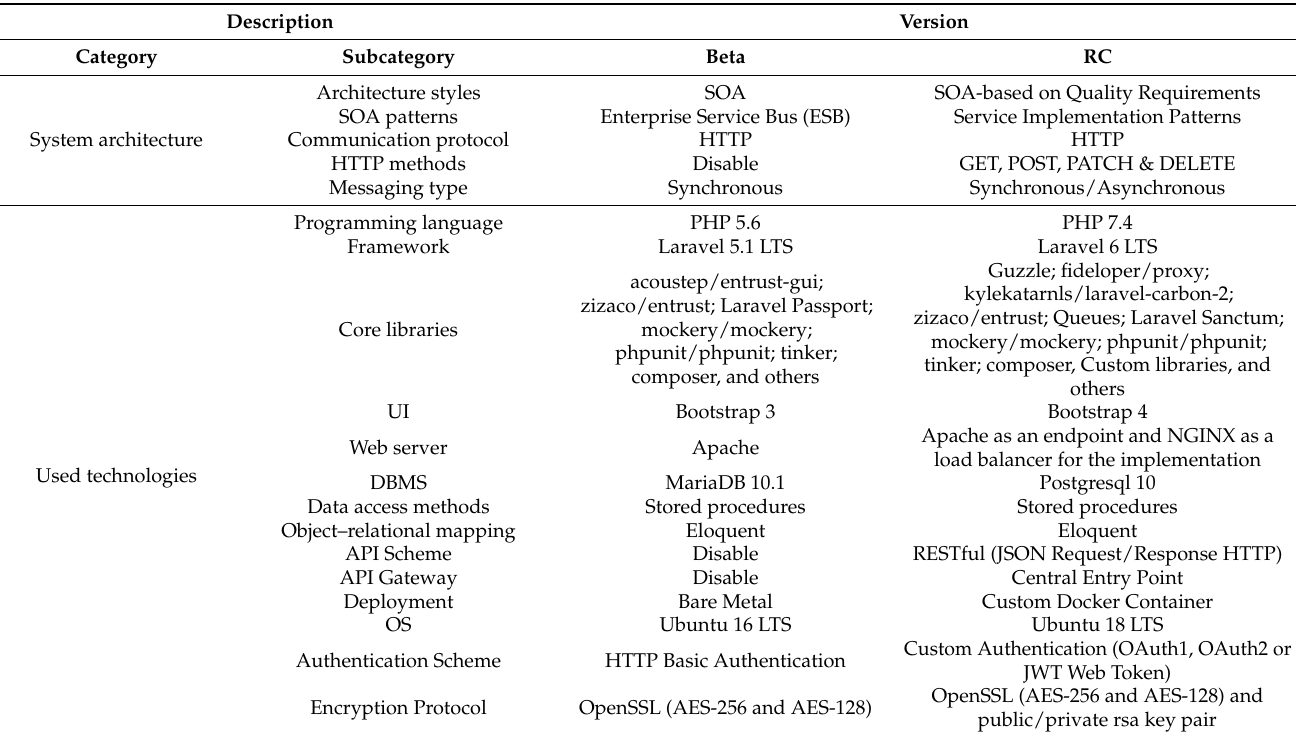
Table 1. General structure in the SPIDEP-SOA